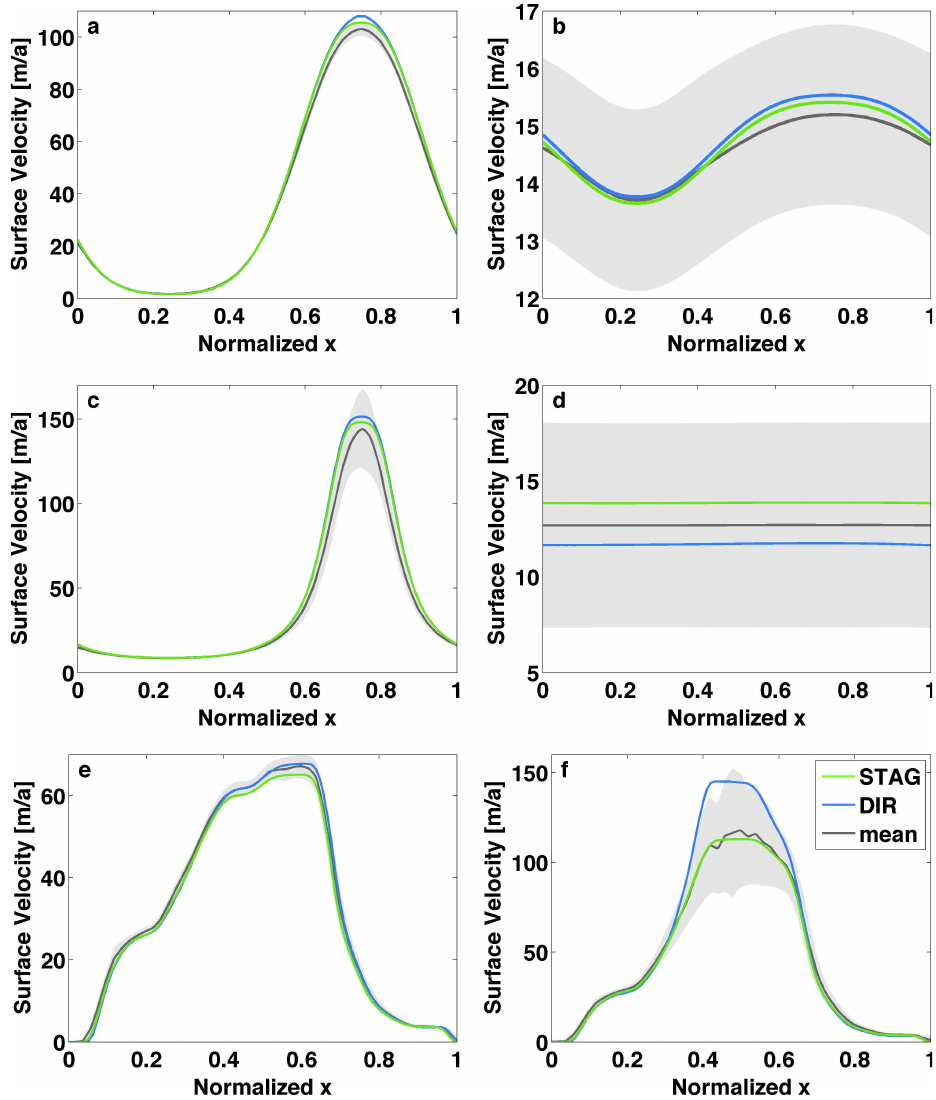
Fig. 3. Resultant surface velocity fields for the ISMIP-HOM model intercomparison of the DIR and STAG discretisations for experiments A on 160km (a) and 5km (b) , C on 160km (c) and 5km (d) and E1 (e) and E2 (f) . The grey shaded area indicates the root mean square (rms) deviation of the solution from each participant compared to the mean benchmark solution (dark grey). For the two discretisations, we chose the solution obtained with the highest possible convergence accuracy (see Table 2). All over the results are in good agreement with the mean of the benchmark test. The only exception is experiment E2 (f) where the DIR velocity field exceeds the wide rms